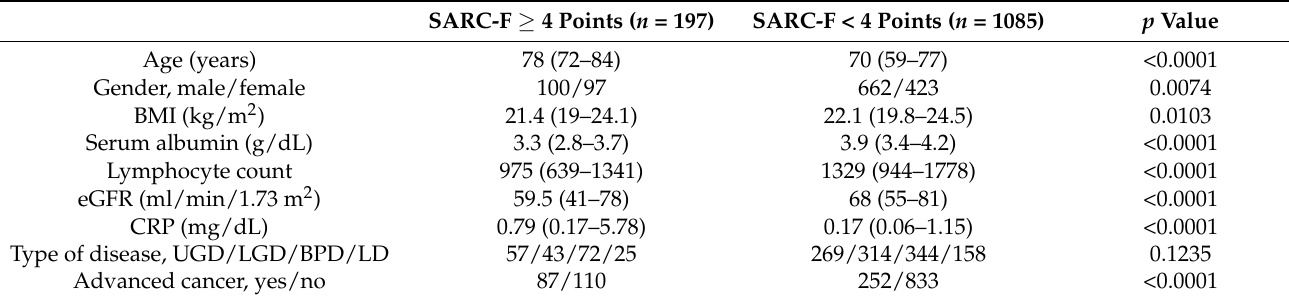
Table 3. Univariate analysis of factors linked to SARC-F ≥ 4 points.